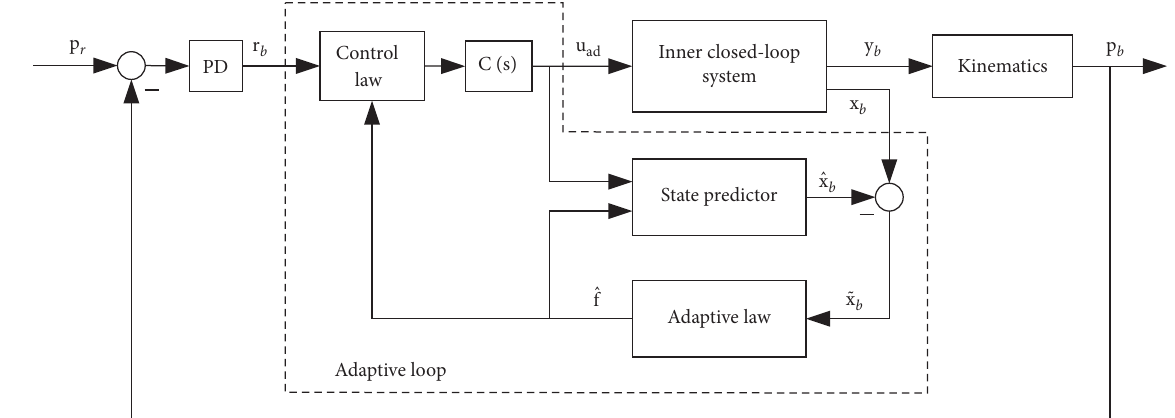
Figure 15: Adaptive controller